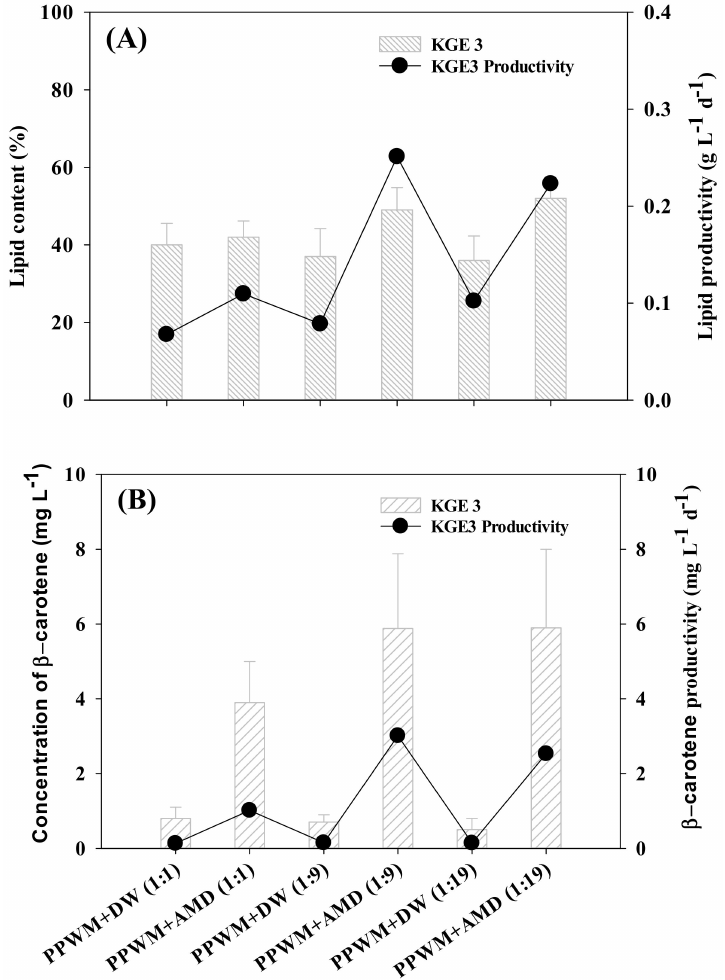
Figure 6. E ff ect of various mixing ratios between pretreated piggery wastewater by membrane (PPWM) and acid mine drainage (AMD) on the lipid production ( A ) and ß-carotene ( B ) of Uronema sp. KGE